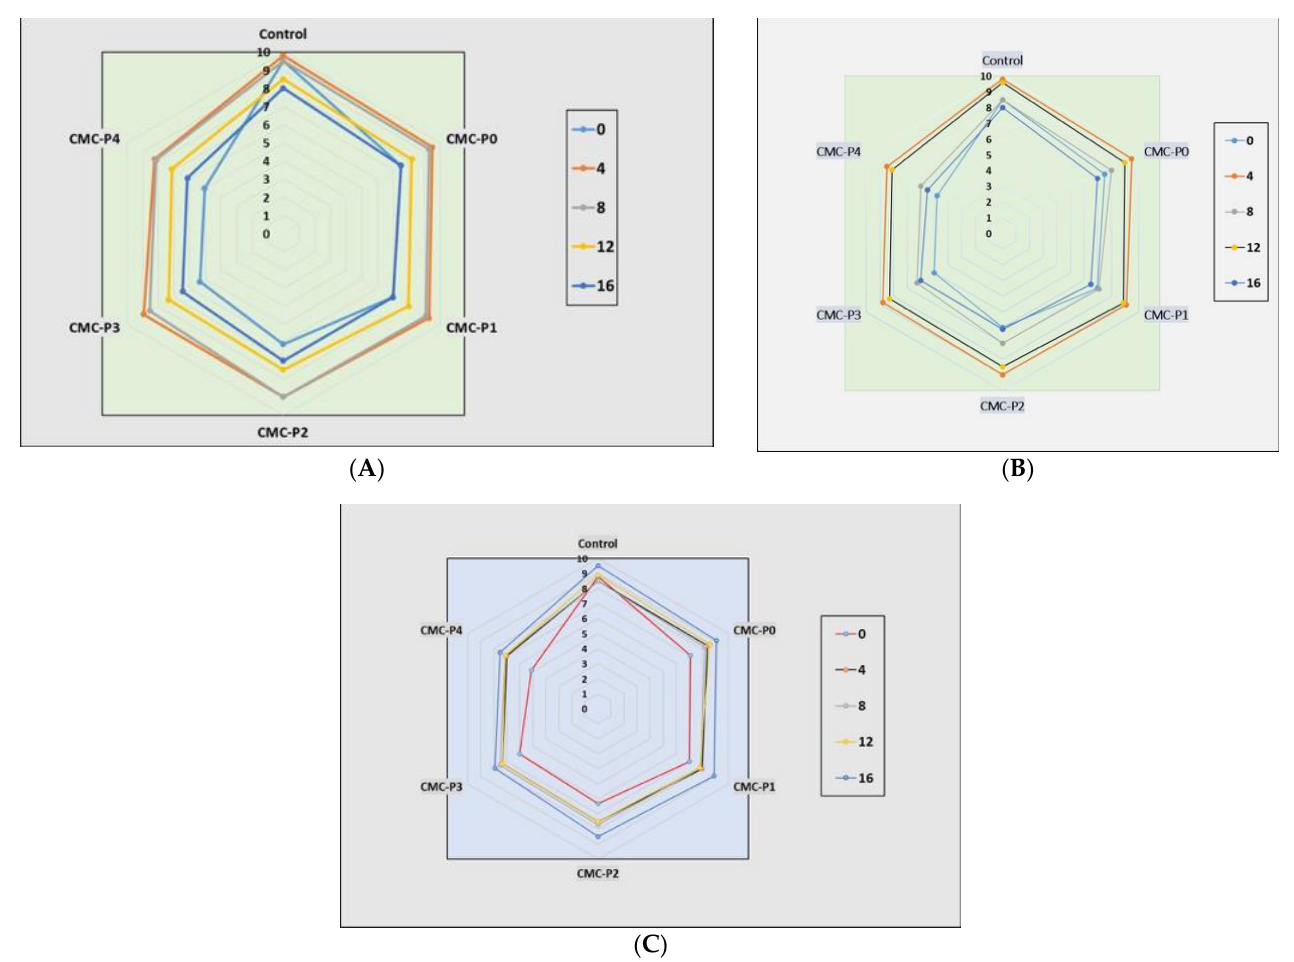
Figure 7. The impact of applied coatings on sensory evaluation: ( A ) color, ( B ) odor, and ( C ) overall acceptability of chicken breast meat samples during storage at 2 °C for 16 days. Control : Uncoated chicken breast meat samples (soaked samples in sterile distilled water). CMC-P0 : CMC-coated chicken breast meat samples with 0% EPE. CMC-P1 : CMC-coated chicken breast meat samples with 1% EPE. CMC-P2 : CMC-coated chicken breast meat samples with 2% EPE. CMC-P3 : CMC-coated chicken breast meat samples with 3% EPE. CMC-P4 : CMC-coated chicken breast meat samples with 4%